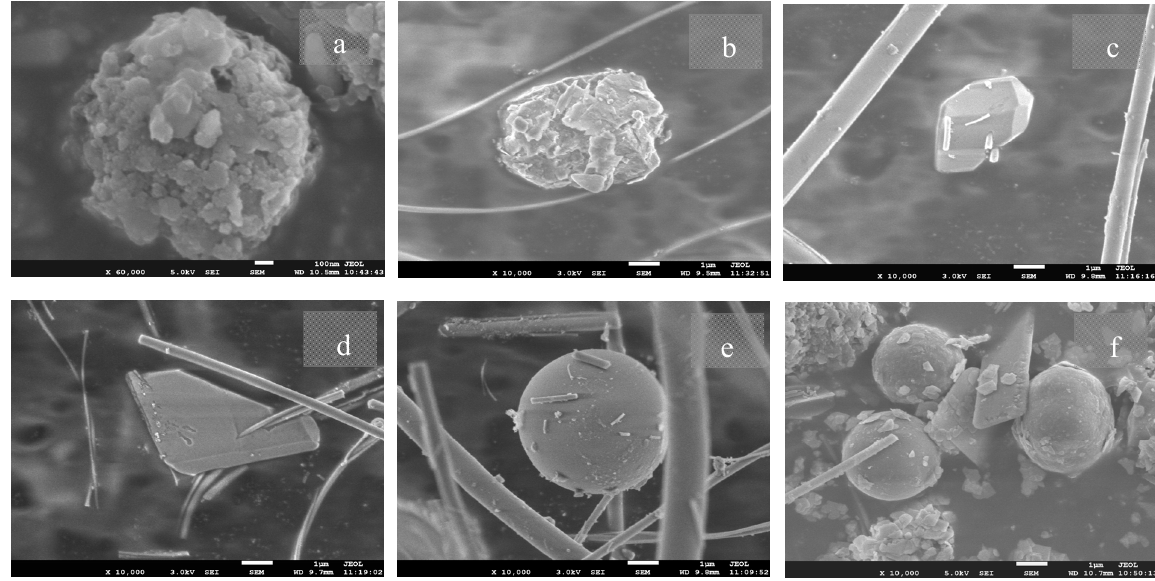
Figure 6. Scanning electron microscopy (SEM) images of atmospheric particles in PM 2.5 at Wutai Mount scenic spot (( a ) in the Wu Ye Temple sampling point; ( b ) in the Yang Bai Lin Village sampling point; ( c ) in the Manjusri Temple sampling point; ( d ) in the Nan Shan Temple Forest District sampling point; ( e ) in the Wu Ye Temple sampling point; ( f ) in the Yang Bai Lin Village sampling